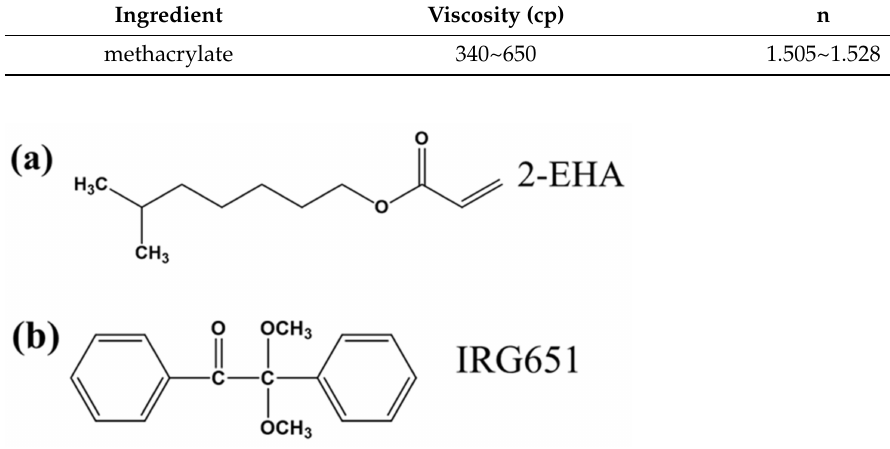
Figure 1. Chemical structures of ( a ) monomer 2-EHA, ( b ) free radical photo-initiator